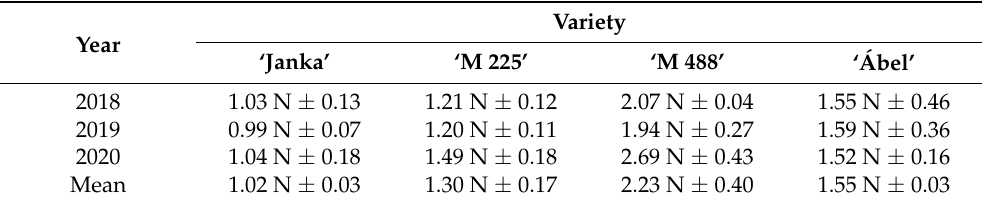
Table 6. The threshing force (TF) values among the varieties and years. Every TF is an average of all measurements data.